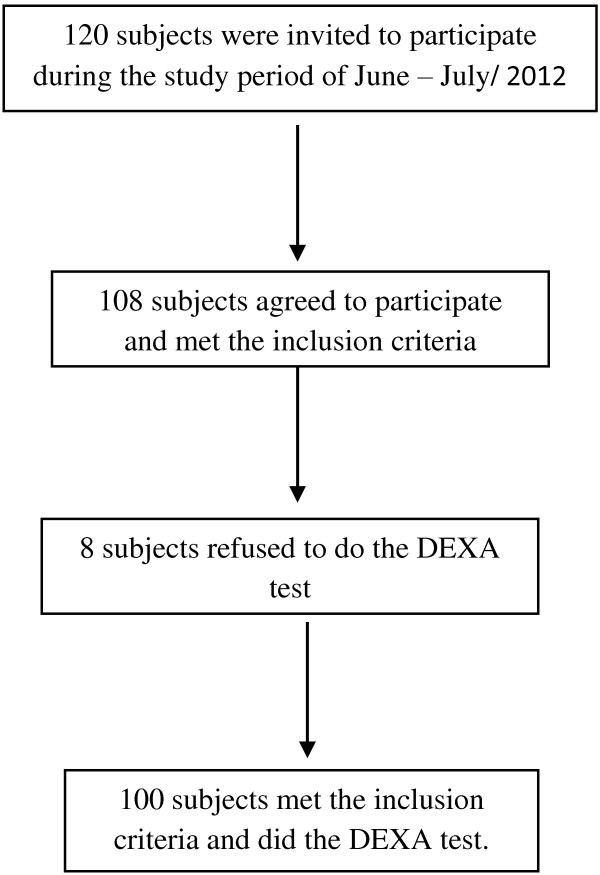
Number and response of subjects who were invited to participate.